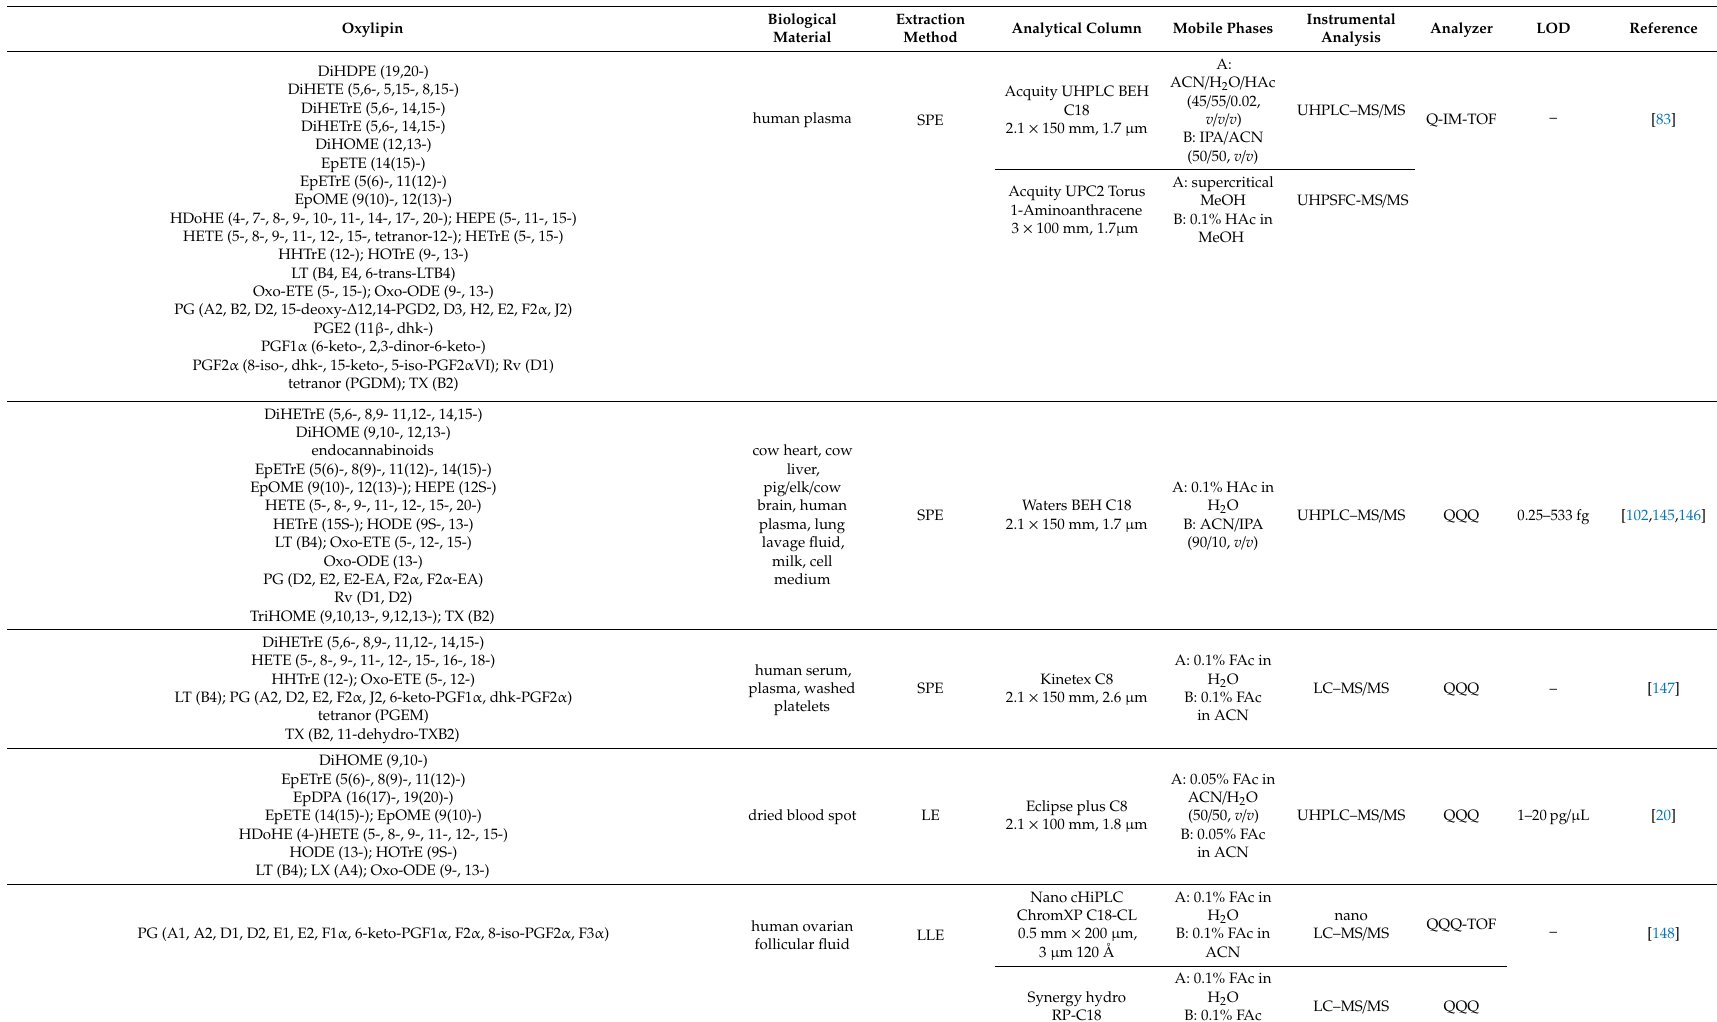
Table 2. Cont. Oxylipin Biological Material Extraction Method Analytical Column Mobile Phases Instrumental Analysis Analyzer LOD